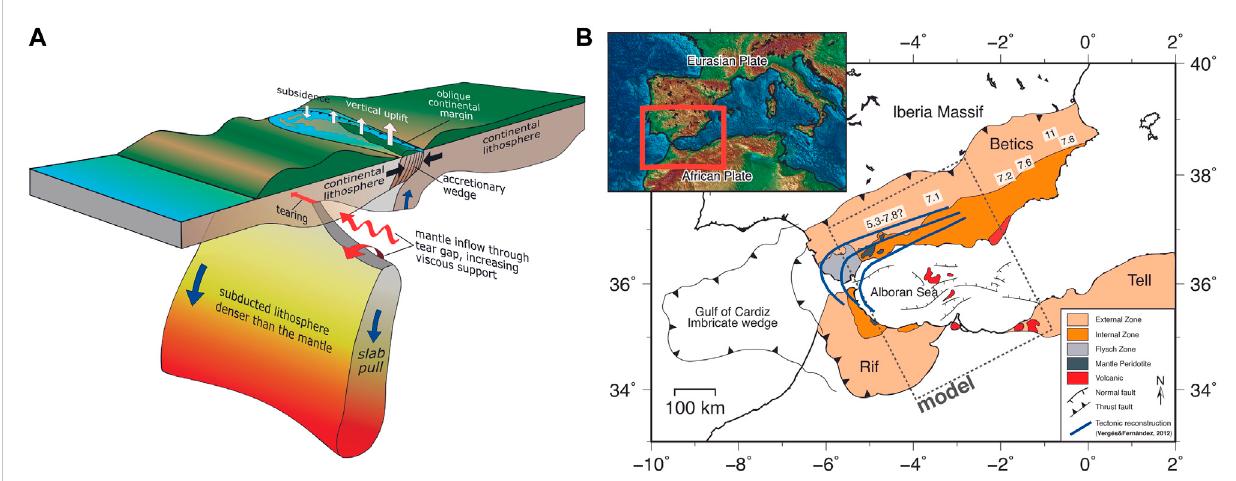
FIGURE 1 (A) Anillustrationofthelithospherictearingprocessandtheroleoflithosphericbuoyancy. (B) GibraltarArcregion(VergésandFernandez,2012).The insetisatopography-bathymetrymap,withourregionofinterestintheredbox.ThemapdisplayskeyunitsoftheGibraltarArcSystem.Thebluelinesare the reconstruction of the slab rollback. The dashed-grey frame outlines the area and the basic features therein, which the model setup is based on. The model frame is at such angle to encapsulate the stages from the reconstruction that involve slab detachment. The numbers in white rectangles are the ages in Ma of the transition from marine to continental conditions of intramountain basins within the Betics (Iribarren et al., 2009; Krijgsman et al., 2018; van der Schee et al.,